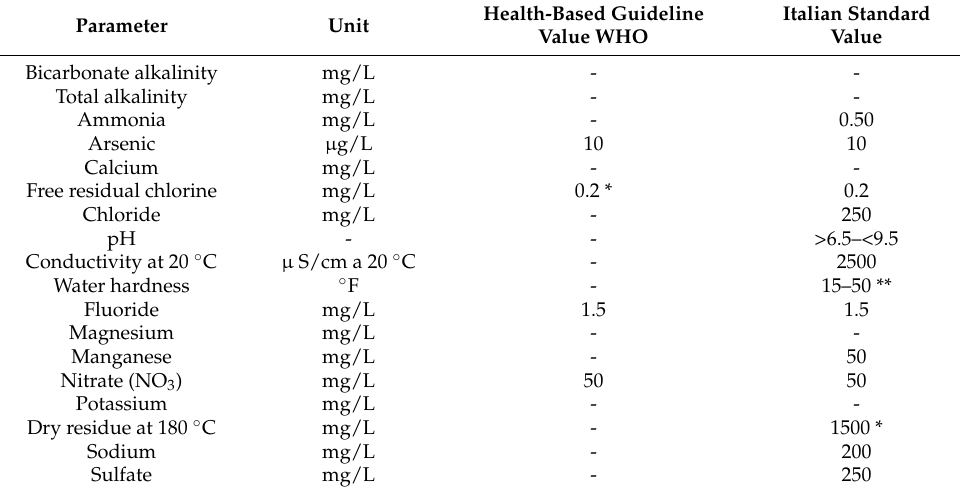
Table 2. Parameters and standard